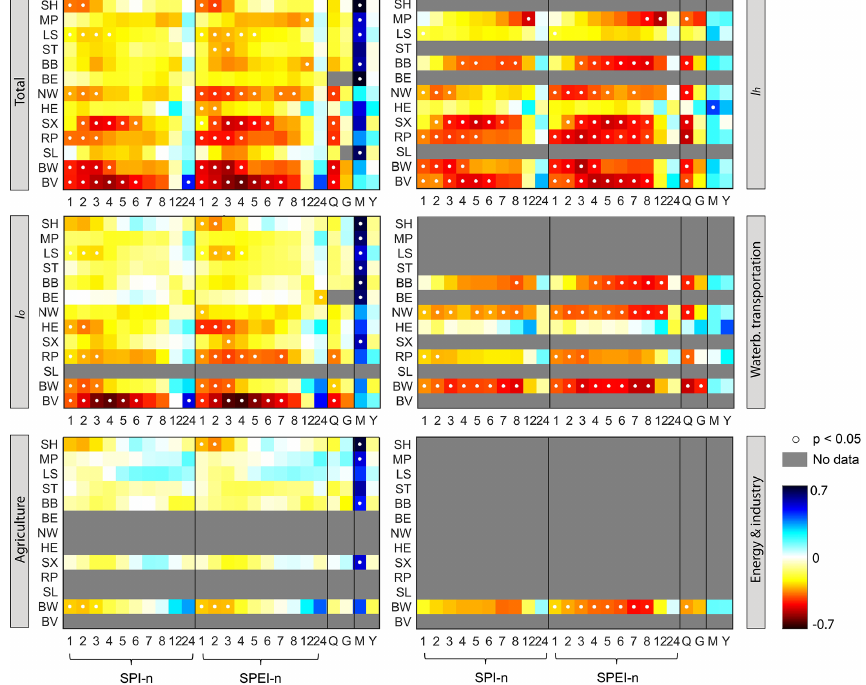
Figure 5. Germany: rank correlation coefficients ( ρ ) between drought indicators and number of impact occurrences for total impacts, hy- drological drought impacts ( I h ), impacts due to other types of drought ( I o ), and selected impact categories per NUTS1 region (Waterb. transportation stands for waterborne